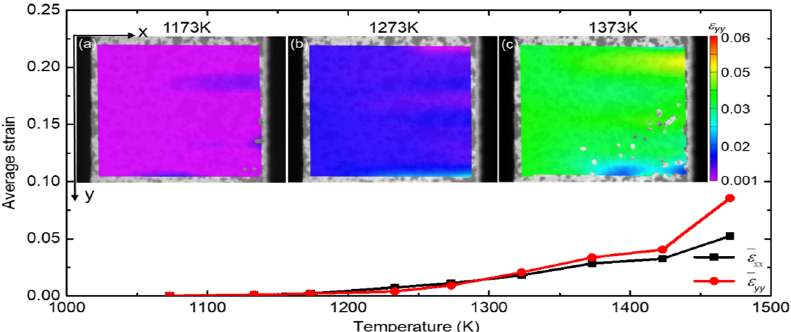
Figure 14. Average thermal strain ⎯ ε xx and ⎯ ε yy with temperature increasing and the typical strain